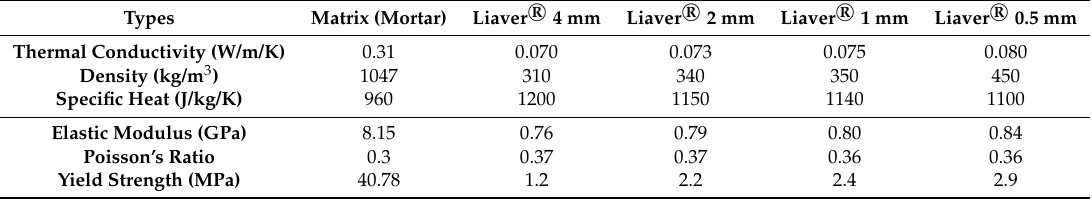
Figure 3. Sample of virtual specimens with different gradings (note: each color denotes spherical (cid:13) Liaver R with different sizes. The total volume of Liaver R Table 6. Material properties of lightweight aggregates (Liaver R (cid:13) ) and matrix [19].